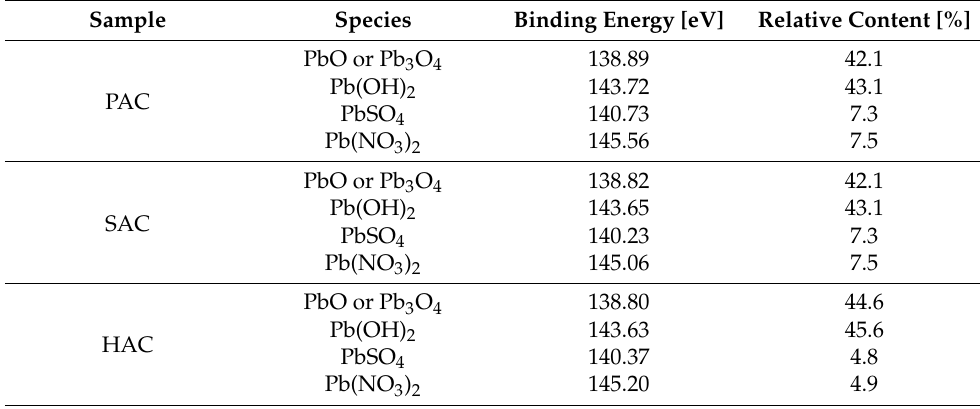
Table 8. The Pb 4f photopeaks of PAC, SAC and HAC activated biocarbons.